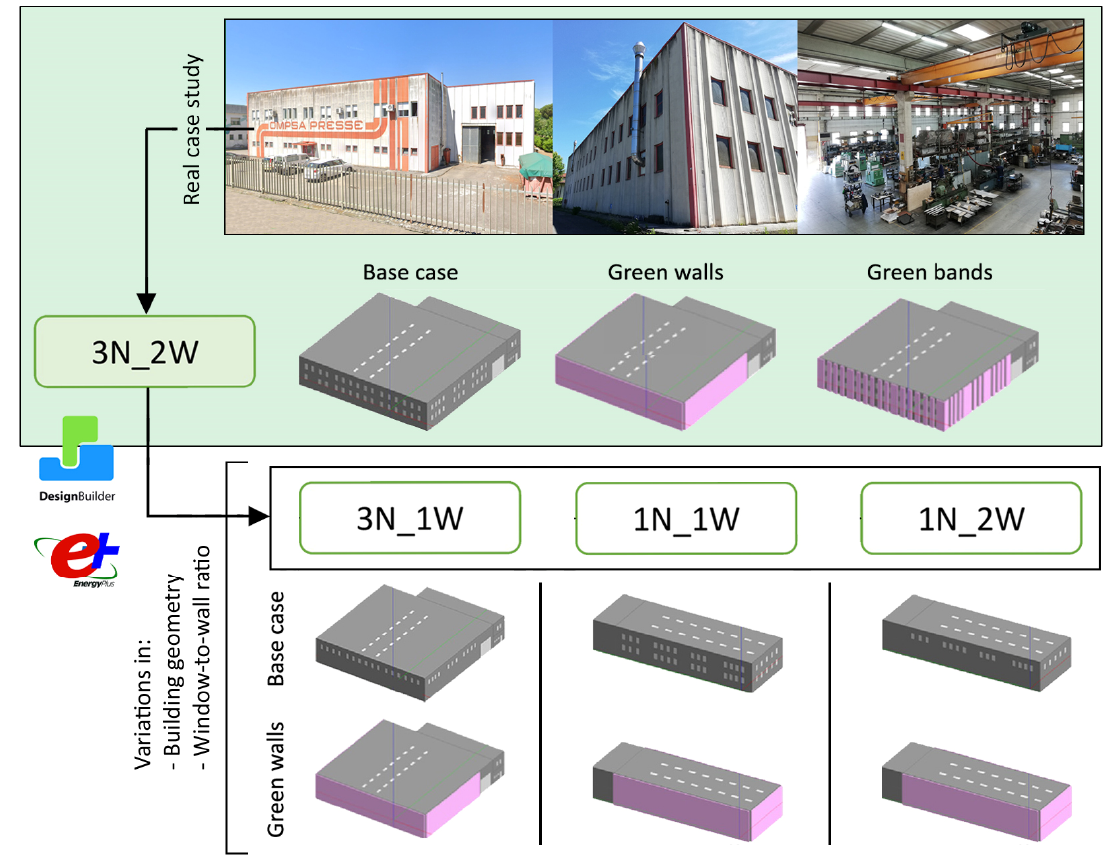
Figure 1. Research workflow and different configurations of simulation models.